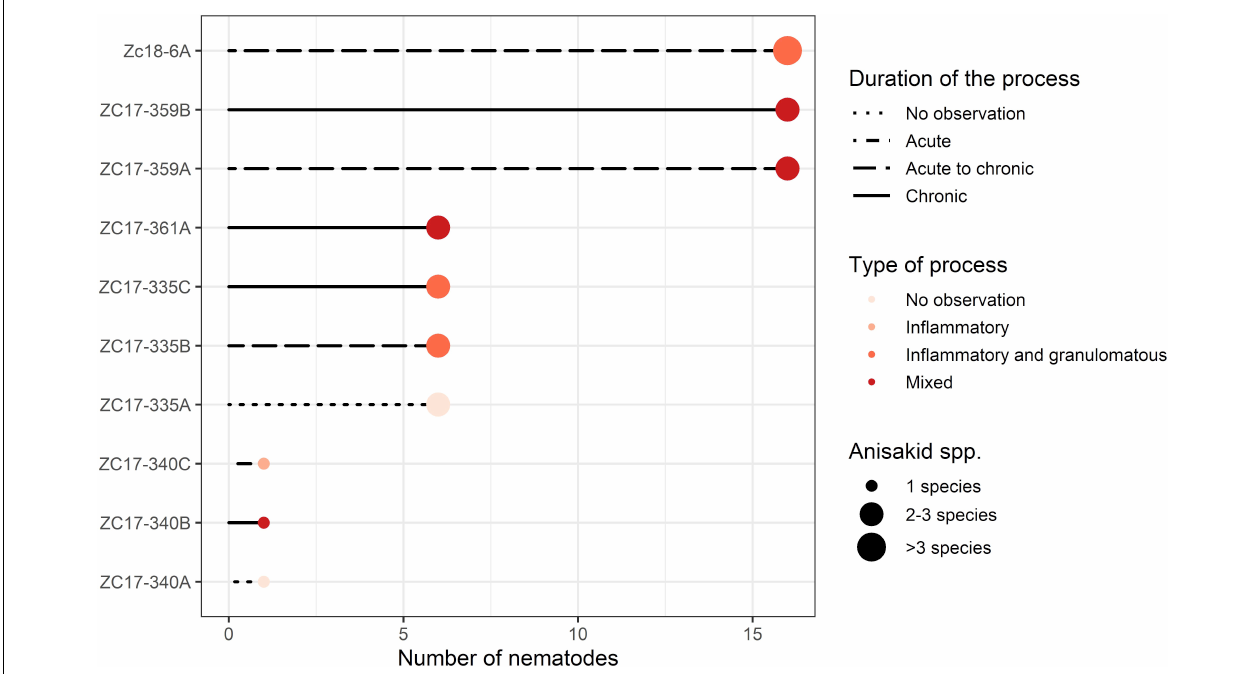
FIGURE 2 | Graphical representation of the severity of lesions inflicted by members of the Anisakidae family per sampled California sea lion ( Zalophus californianus ). Animals and lesions are depicted on the y -axis and abundance of nematodes coded on the x -axis: 1 (1–5), 6 (6–15), and 16 ( > 16) nematodes found in the lesion. Other criteria chosen to score severity (duration and type of process and number of species found) are depicted according to the legend in the graph.